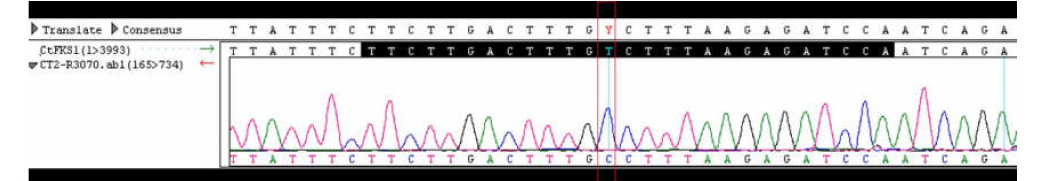
Figure 2. DNA sequencing chromatograms for Candida tropicalis isolate 2 strain isolated from blood of Index case # 2. HS1 sequence is shown in black in the reference strain ATCC750 used as control. The red box indicates the T-to-C